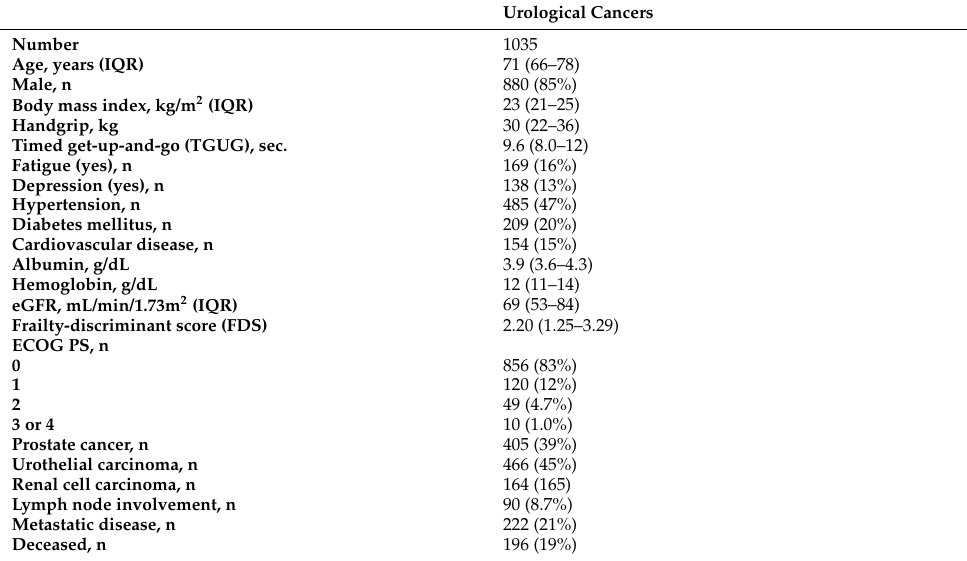
a negative value means less frail. Table 2. Background of